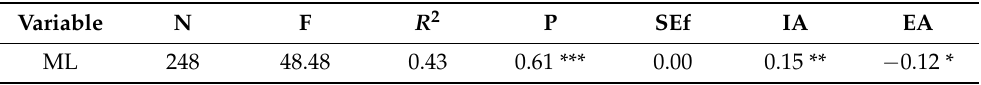
Table 2. Regression analyses of the relationships between meaning in life and the independent variables. Variable N F R 2 P SEf IA EA ML 248 48.48 0.43 0.61 *** 0.00 0.15 ** − 0.12 *